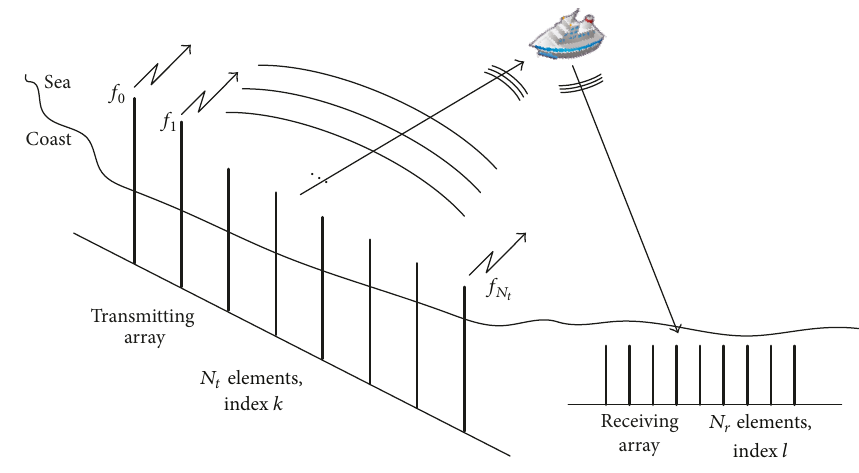
Figure 1: A MIMO HFSWR system.